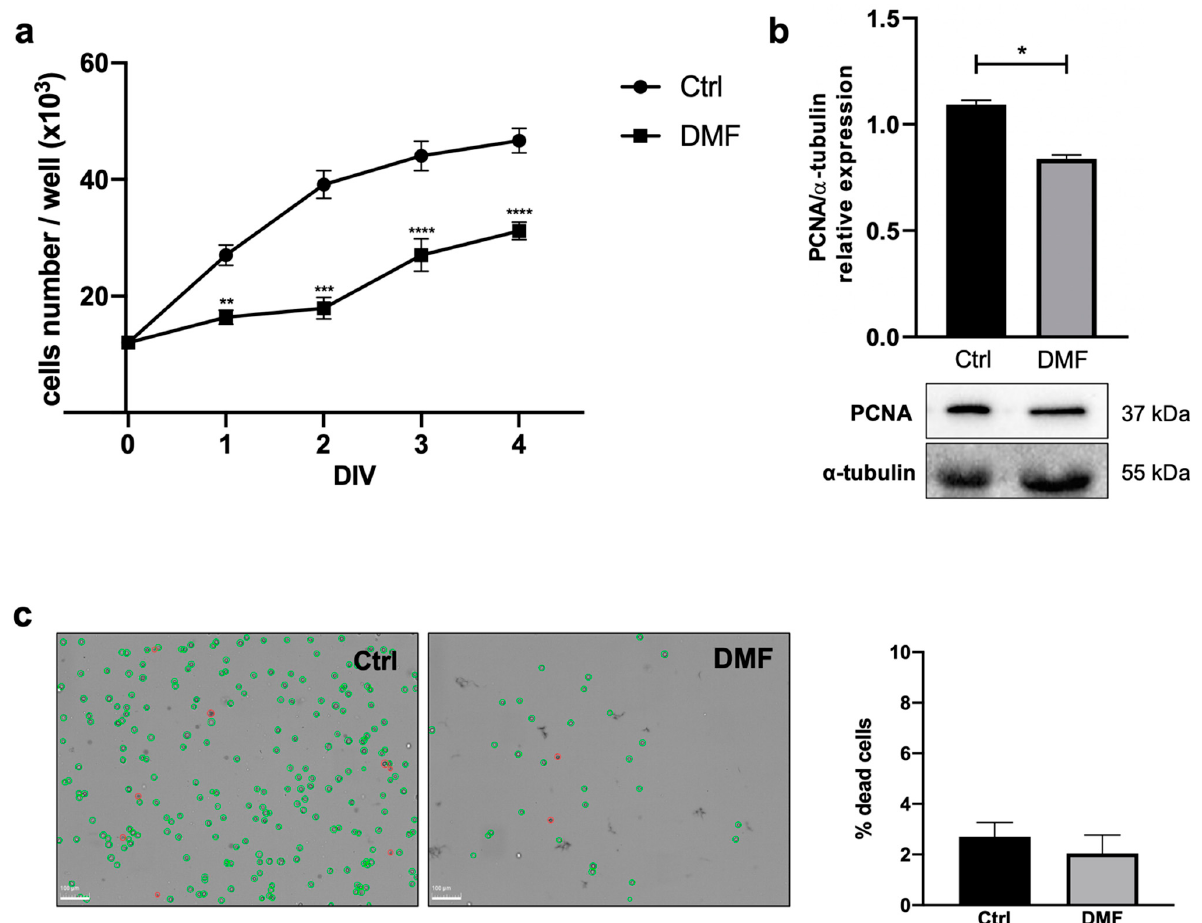
Figure 3. ( a ) Analysis of Oli neu cells growth by MTT assay in the control condition (DMSO) and after DMF 25 µ M treatment (1, 2, 3, 4 DIV; days in vitro). Data are presented as mean ± SEM of three independent experiments performed in quadruplicate. Student’s t -test was used to statistically compare vehicle and treatment condition at each different experimental time (** p < 0.01, *** p < 0.001, **** p < 0.0001). ( b ) Representative western blot for PCNA protein expression in Oli neu cells in control (DMSO) and after 72 h of 25 μ M DMF treatment. α -tubulin was used as internal reference protein. Densitometric analysis showed in the graph was obtained from three independent experiments. Student’s t-test was used to statistically compare the different experimental conditions (* p < 0.05). ( c ) Cell viability was assessed by cell counting. Oli neu cells were plated in triplicate, treated with vehicle (DMSO) or DMF 25 μ M. After 72 h of treatment, cells were counted by LUNA-FX7™ using trypan blue dye, as shown by the representative images (live cells in green; dead cells in red). The graph shows the percentage of dead cells in the two experimental conditions; it is representative of three independent experiments. Student’s t-test was used to statistically compare the different experimental conditions (n. s. p = 0.4216).